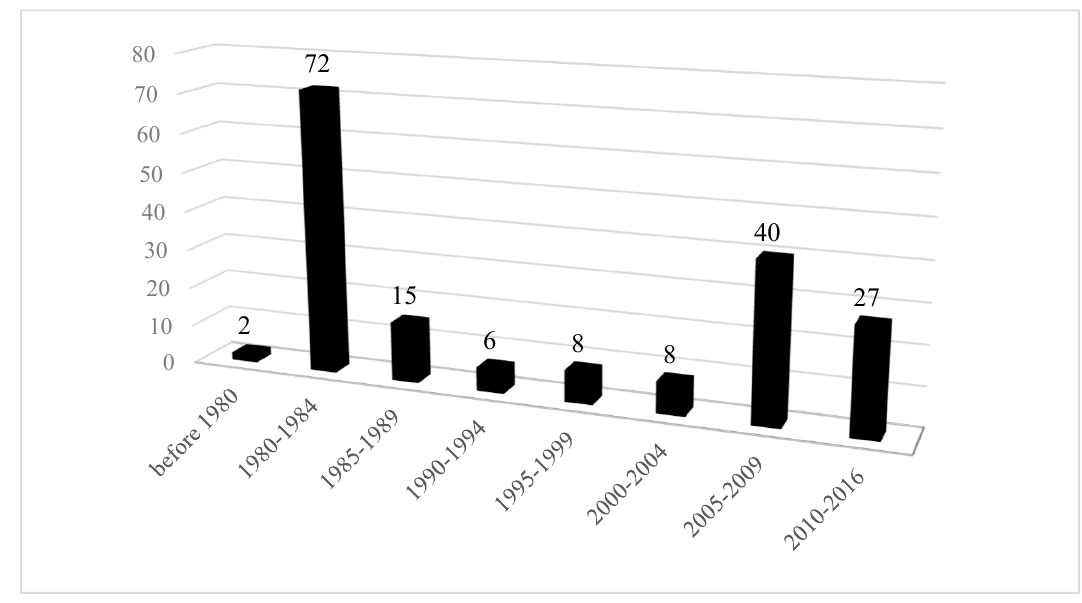
Figure 1. Amount of news coverage over time.